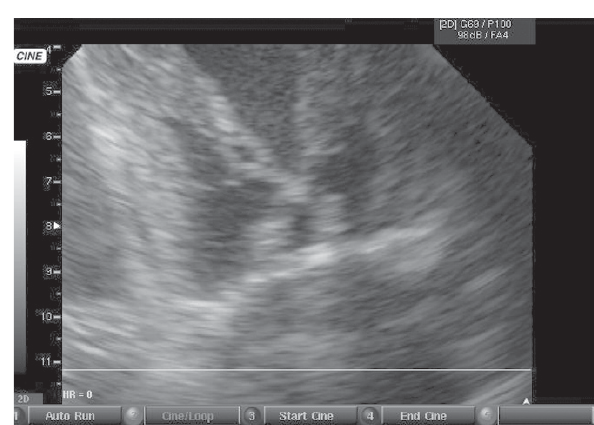
Fig. 3 - Imagem ecocardiográfica pós-operatória mostrando o cruzamento dos músculos papilares.